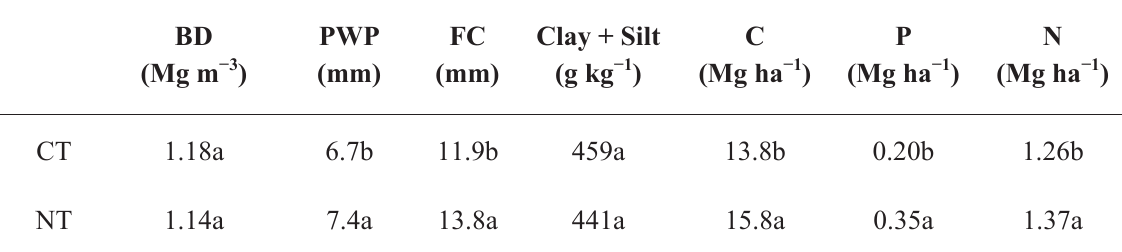
Table 1. Bulk density (BD), water content at permanent wilting point (PWP) and at field capacity (FC), clay plus silt contents (particles <50 μ m diameter), total organic carbon (C), available phosphorus (P) and total nitrogen (N) of conventional (CT) and no till (NT) treatments (Average values for 0–0.18 m depth).